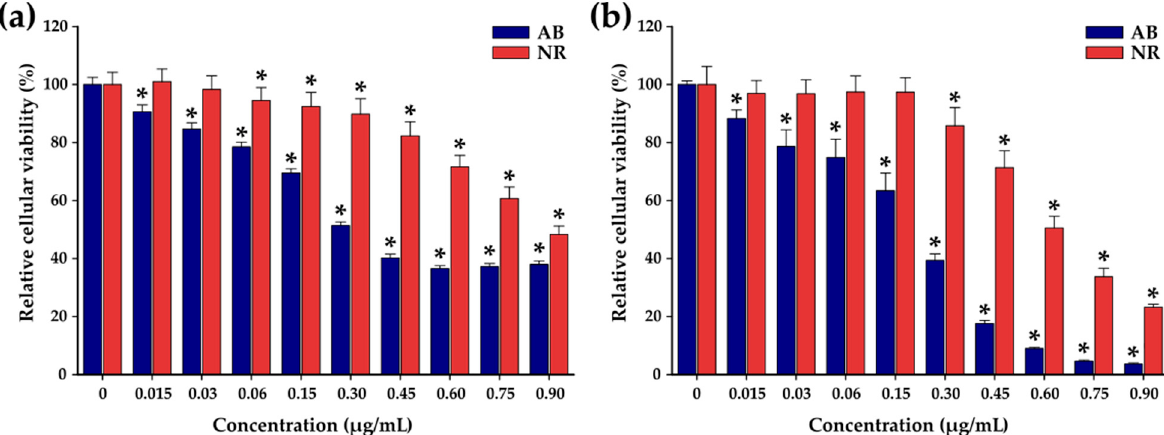
Figure 3. Cytocompatibility of doxorubicin on A549 cell line after ( a ) 24 h and ( b ) 48 h exposure. Data are presented as relative values to the negative control (100%), as mean ± SD of three biological replicates. The significant differences compared to the negative control (ANOVA + Dunn’s; p < 0.05) are noted with asterisks (*).